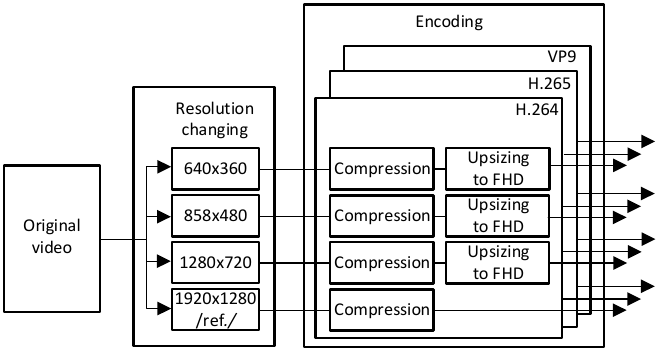
Figure 3. Video sample preparation procedure.